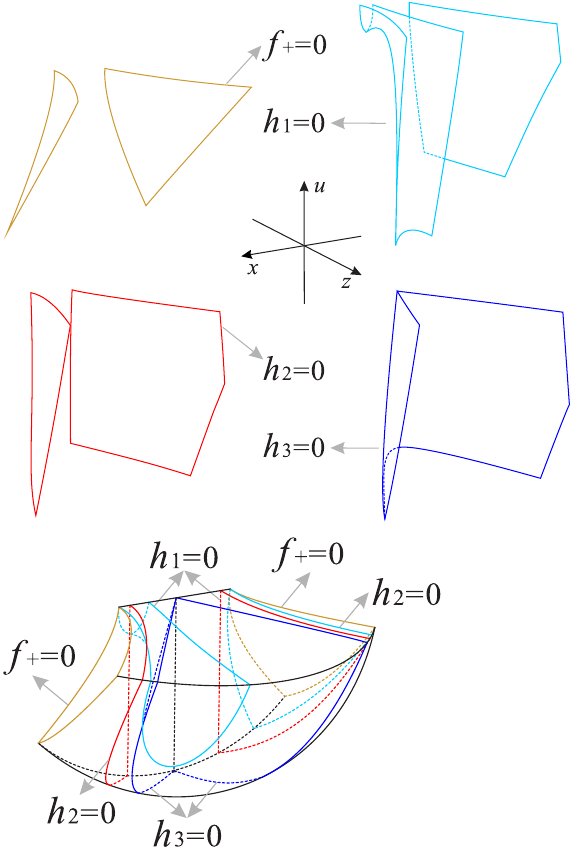
Figure 22. The surfaces h 1 , h 2 and h 3 restricted to the invariant surface f + ( x , z , u ) = 0 and the region R 2 of the Poincaré ball.